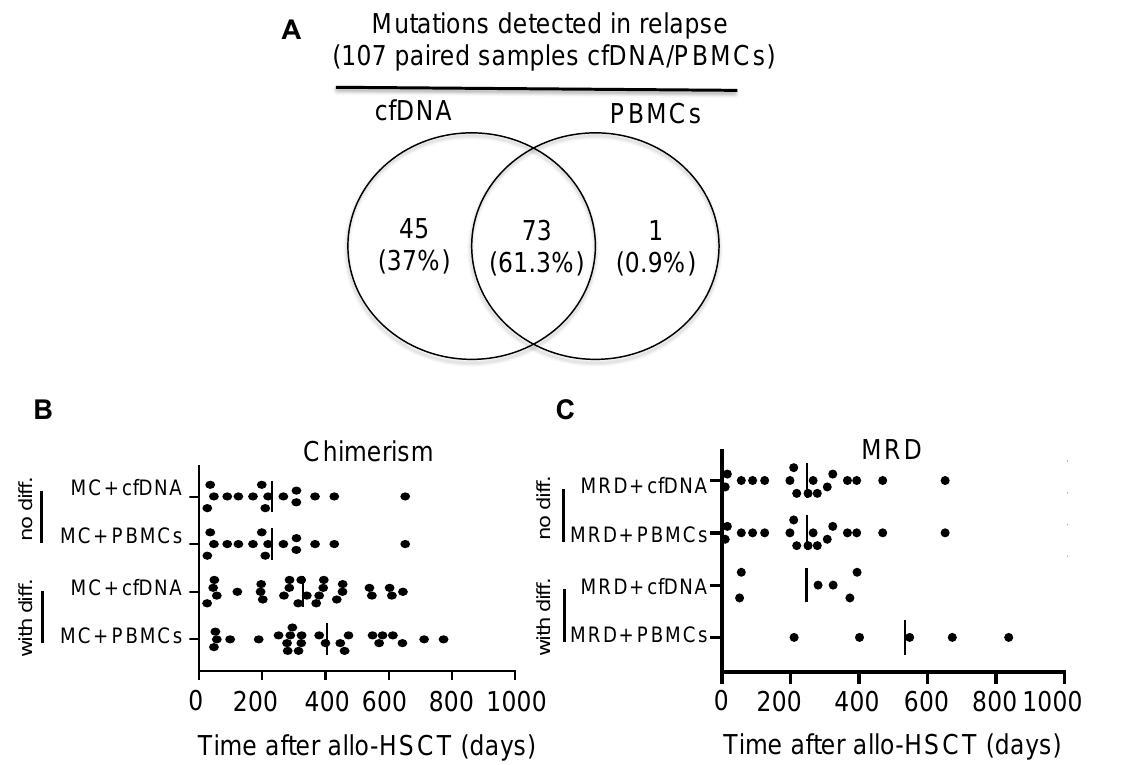
Figure 3 . Kinetics of mixed chimerism and measurable residual disease in cfDNA and in PBMCs after allo-HSCT. ( A ) Comparison of mutations detected in paired PBMC and cfDNA samples ( n = 119) included in this study. Most of the mutations were detected in both, PBMCs and cfDNA ( n = 73, 61.3%) and a part of the mutations only in cfDNA but not in PBMCs ( n = 45, 37%). ( B , C ) Graphs represent the time to first detection of MC and MRD after allo-HSCT in patients, respectively. Groups of patients were divided, if MC or MRD was detected simultaneously in paired samples (no diff.) or consecutively (with diff.). One patient died because of pneumonia (non-relapse mortality) with MRD detected in cfDNA but not in PBMCs. cfDNA, circulating-free DNA; PBMCs, peripheral blood mononuclear cells; allo-HSCT, allogeneic hematopoietic stem cell transplantation; MRD,